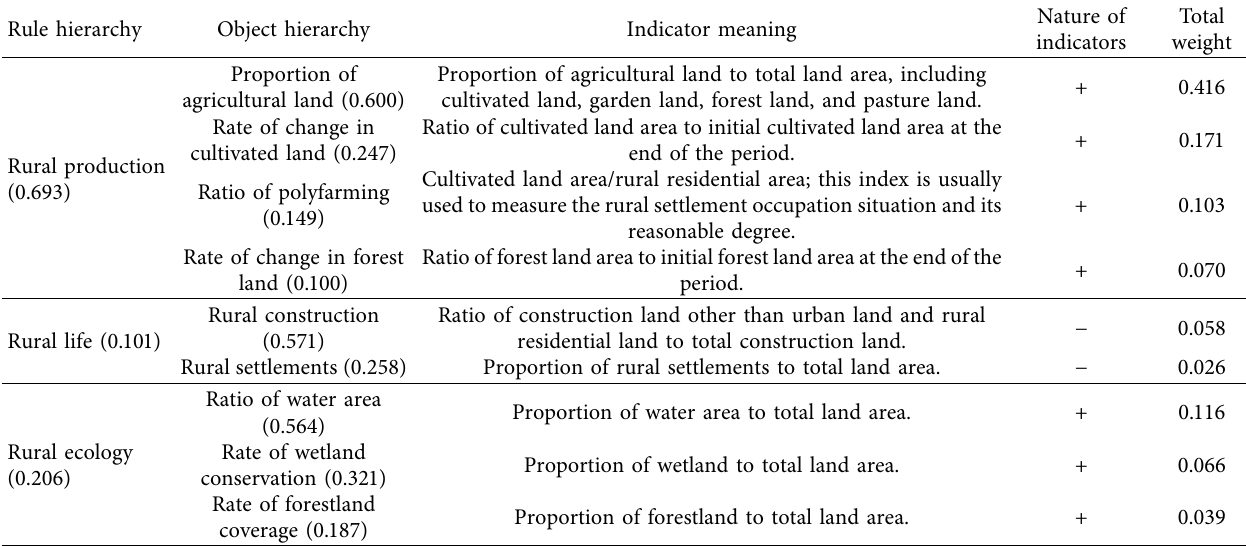
Table 1: Rural evaluation